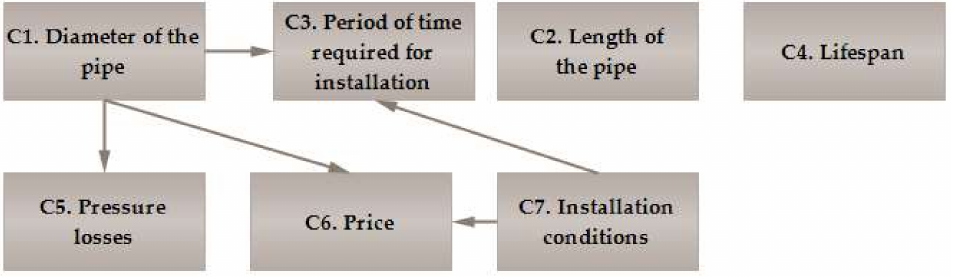
Figure 4. Relationships between the decision-making